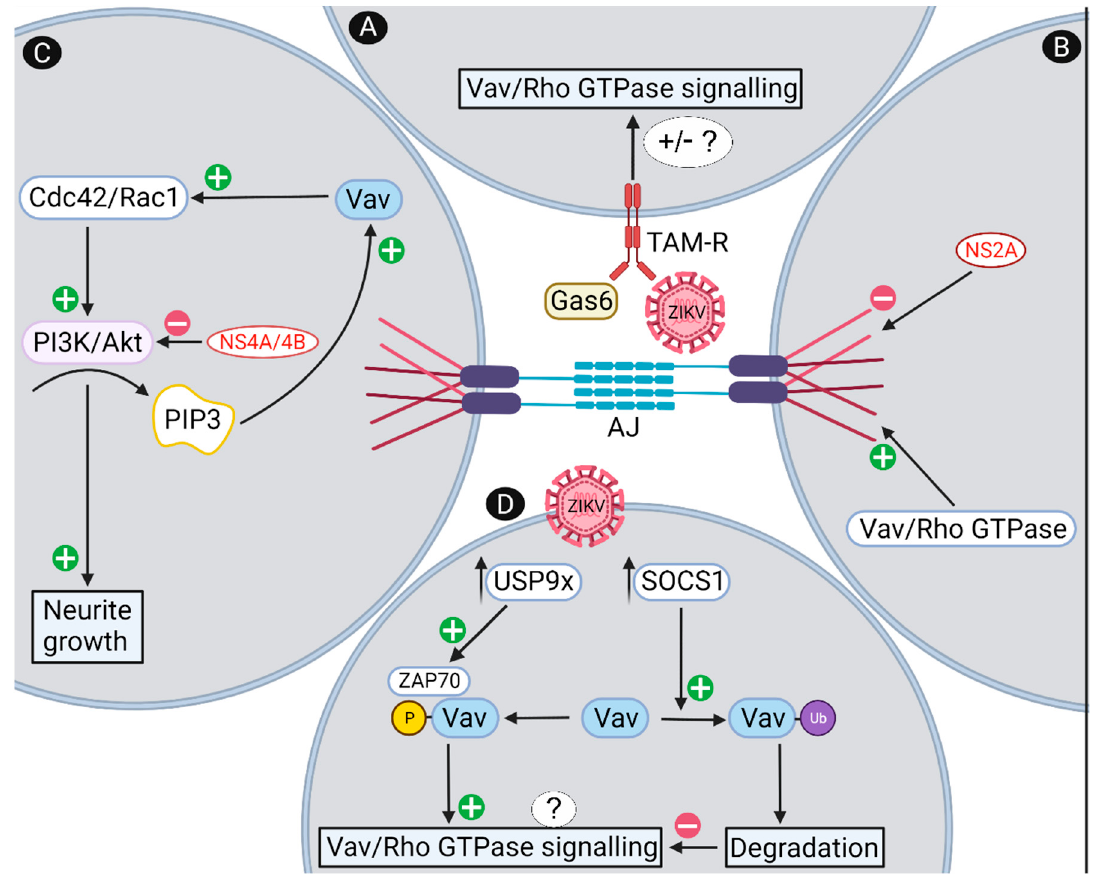
Figure 3. Proposed mechanisms by which ZIKV may affect Vav and Rho GTPase signaling. ( A ) ZIKV can bind and enter cells via TAM receptors, including through an interaction with the TAM ligand Gas6, which can signal via Vav and Rho GTPases with unknown outcomes for this signaling pathway; ( B ) ZIKV NS2A binds to and disrupts adherens junctions, a structure that is regulated by Vav and Rho GTPases, with Vav itself a potential adherens junction component; ( C ) ZIKV NS4A/B inhibits the PI3K/Akt pathway, which is part of a positive feedback loop via PIP3 activation of Vav to drive neurite outgrowth; ( D ) ZIKV induces SOCS 1 and USP9X expression which can affect Vav ubiquitination (Ub) and proteosomal degradation, or ZAP70-induced Vav phosphorylation, which would be predicted to influence Vav activation of Rho GTPases. Predicted outcomes are reduced adherens junctions’ formation and alterations in the actin cytoskeleton that affect the polarization and NPC environment leading to a reduced NPC pool. In neurons, reduced Vav/RhoGTPase signaling is predicted to lead to reduced neurite outgrowth or growth cone collapse, affecting the dynamic changes that influence development of the complex brain architecture. AJ = adherens junctions. Created with BioRender.com https://biorender.com (accessed 7 January 2022).